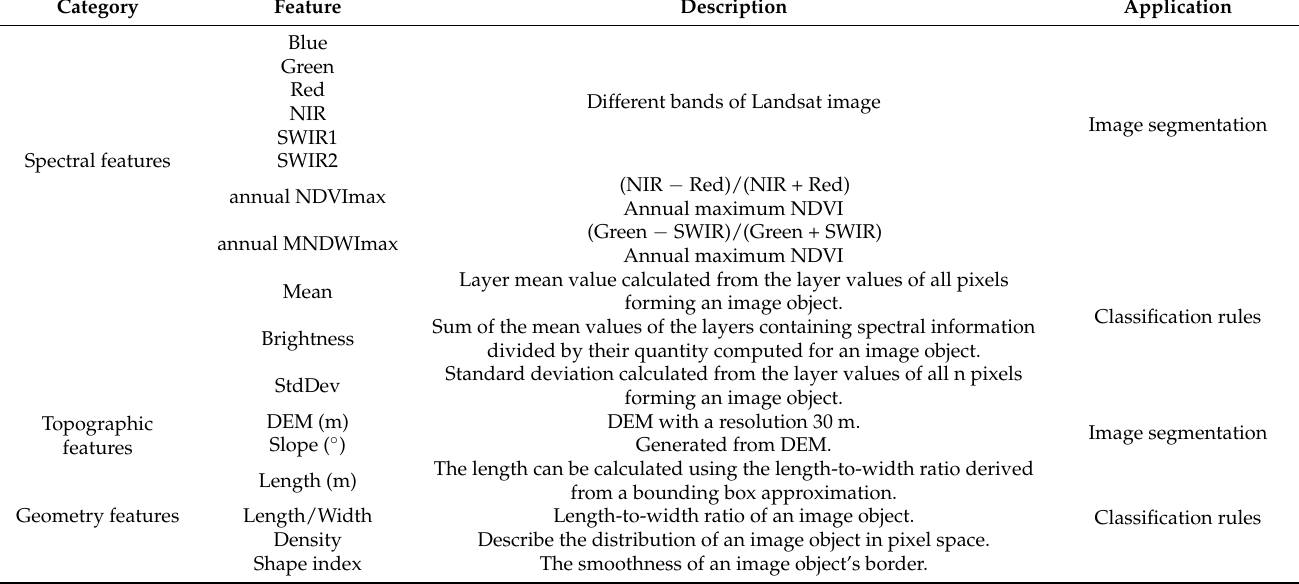
Table 2. The image segmentation index and classification features used in object-based